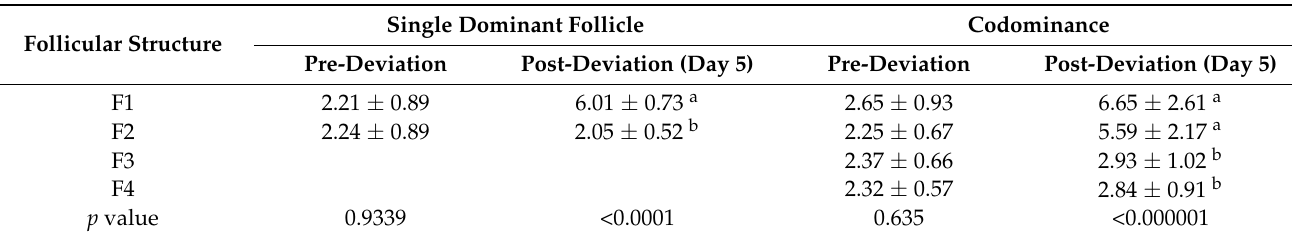
Table 2. Follicle diameter in llamas ( Lama glama ): single DF vs. codominance